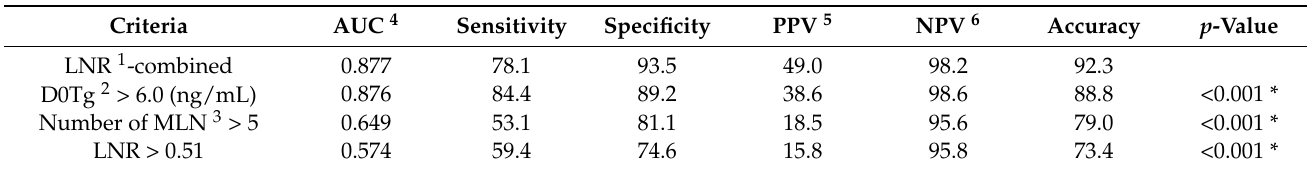
Table 3. Comparison of the diagnostic performance for the detection of FDG-avid persistent disease based on PET/CT indication identified using the suggested criteria.